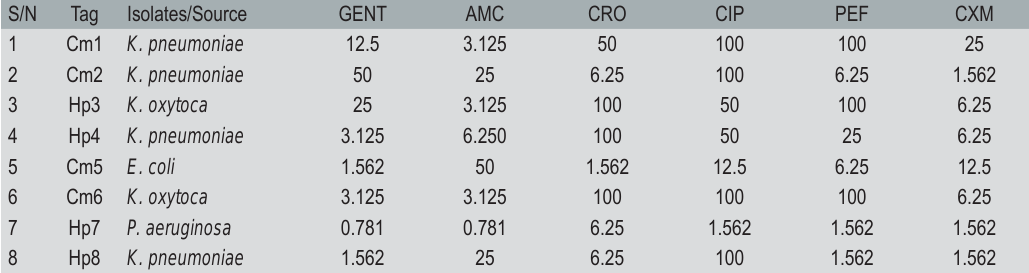
TABLE 1. Minimum Inhibitory Concentration for Organisms (MIC) ( μ g/ml)